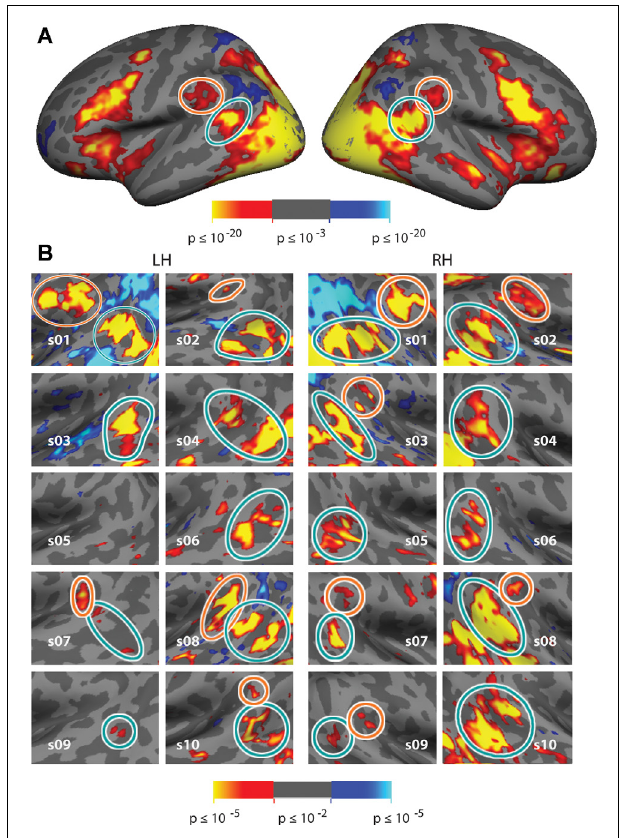
FIGURE 3 | Vivid, Novel Oddball effect in group average and in individual subjects. (A) Group average analysis ( N = 10; cluster correction threshold of p < 0.01) of oddball vs. non-oddball trials reveals robust activation in bilateral temporoparietal junction (TPJ) and indicates two distinct patches of activation falling within the region of the TPJ: a large bilateral posterior patch (“TPJ STS ,” cyan circle), spanning both banks of the STS, and a smaller bilateral anterior patch (“TPJ SMG ,” orange circle) in the ventral portion of the Supramarginal Gyrus (SMG). (B) Zoom-in of the same analysis shown in each individual subject ( p < 0.01, uncorrected; see also Supplementary Figure S4 for contrast effect